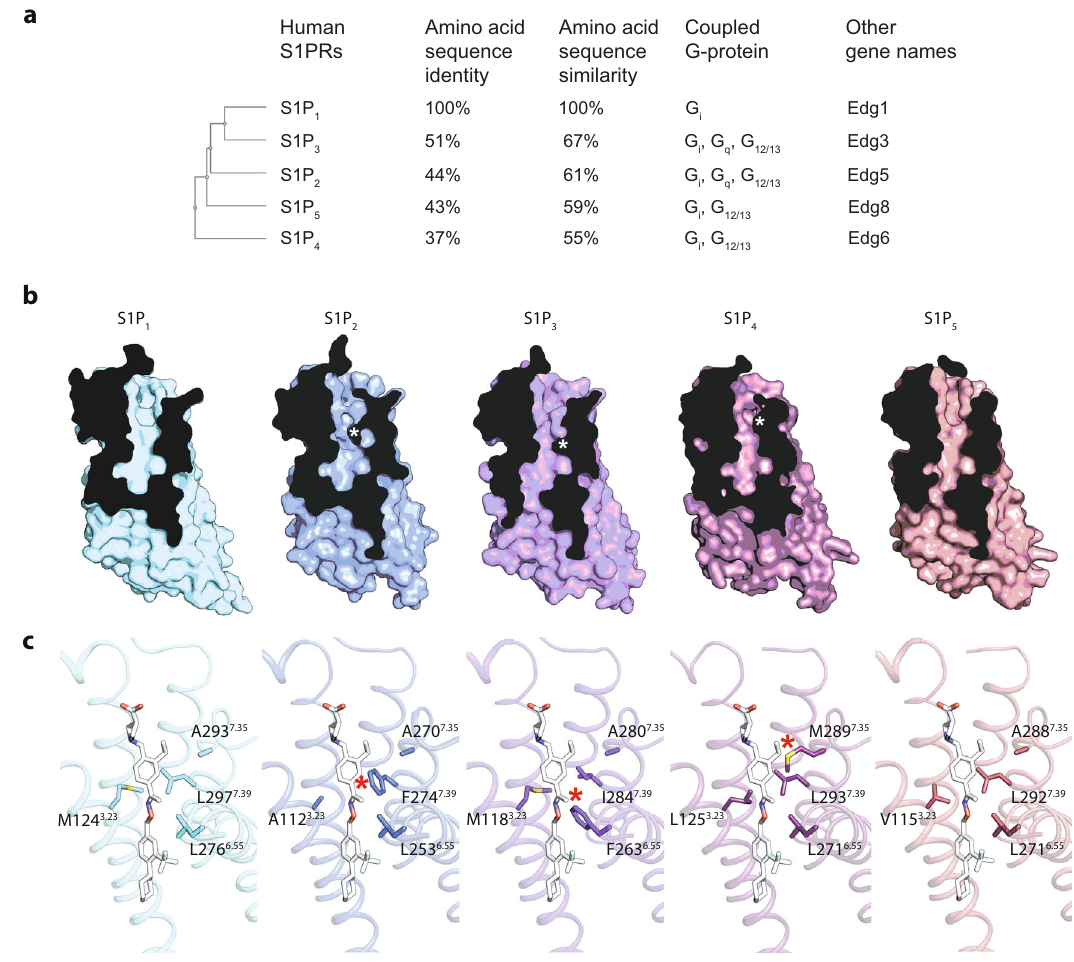
Fig. 6 S1P receptor classi fi cation and modeled structures. a Classi fi cation, sequence homologies, coupled G-proteins and other names of S1P GPCRs. b Slice views of the orthosteric binding sites of S1P 1 and the modeled S1P 2-5 . c Docking of Siponimod into the fi ve S1P receptors. * indicates the clashes.